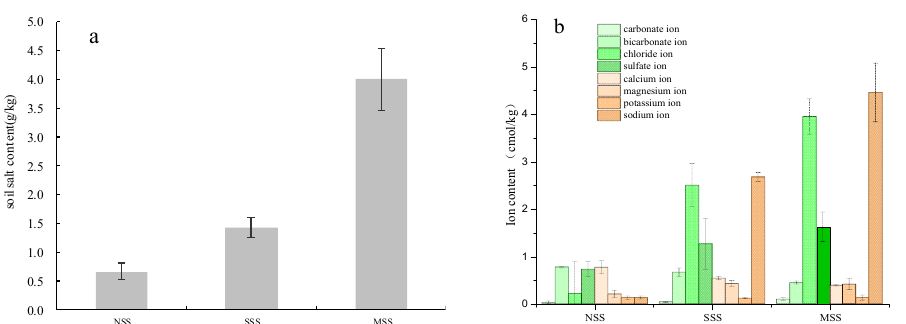
Figure 4. Salt content and soluble ion under different salinity environment. (( a ): salt content; ( b ): soluble ion).